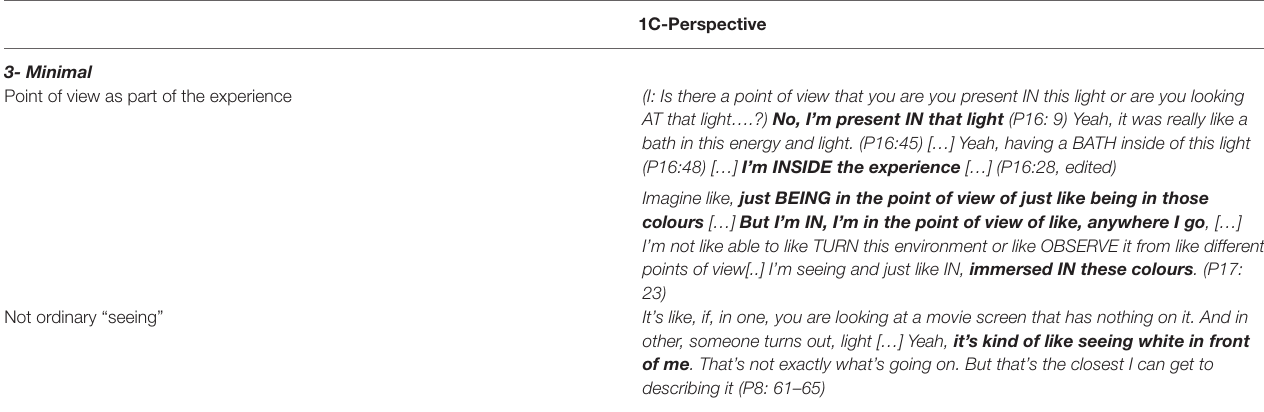
TABLE 4 | Examples of quotes referring to a “ Minimal ” sort of first-person perspective of point of view and the different ways in which it is instantiated.